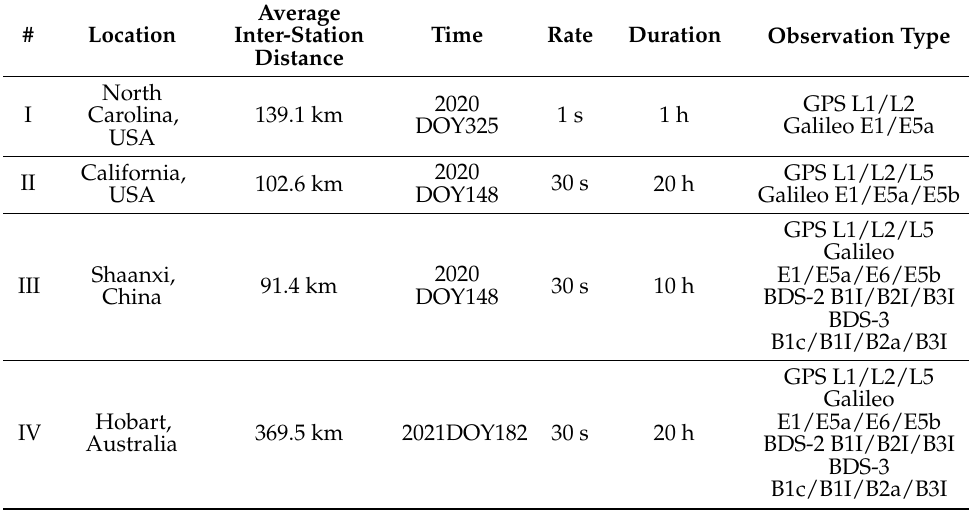
Figure 2. Global MGEX stations distribution for multi-frequency FCB estimation. Table 2. Detailed information of the four sets of reference network